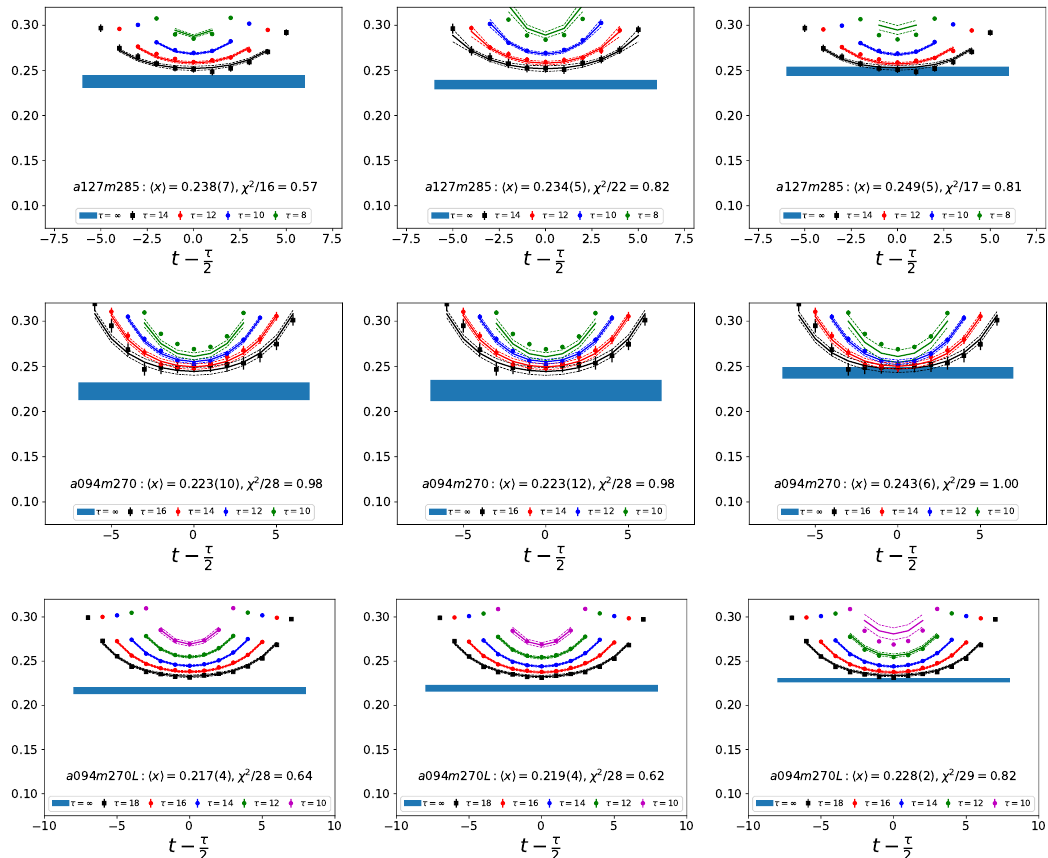
Figure 9 . Data and fits to remove excited-state contamination in the extraction of the transversity moment h x i for a 127 m 285 (top row), a 094 m 270 (middle row), and a 094 m 270 L (bottom row) δu − δd ensembles. The data for the ratio C 3 pt ( τ ; t ) /C 2 pt ( τ ) is scaled using eq. (3.10) to give h x i O the fit parameters are listed in table 9. The rest is the same as in figure